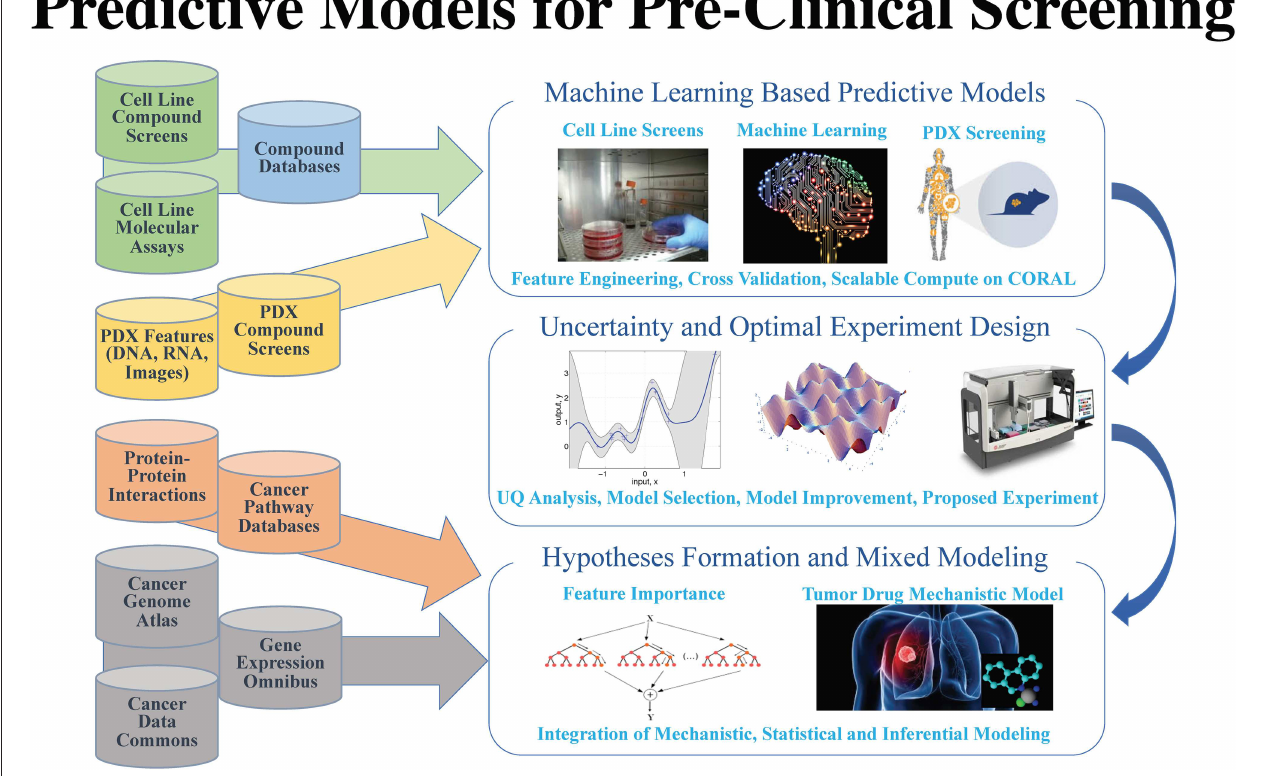
FIGURE 1 | Pilot 1 research aims, general workflow, and supporting